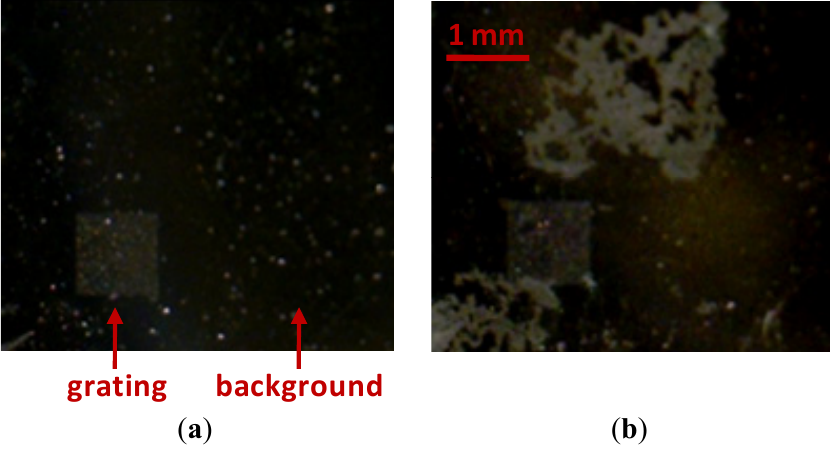
Figure 4. Example of oxidized Al surfaces degradation, before ( a ) and after ( b ) interacting with PBS